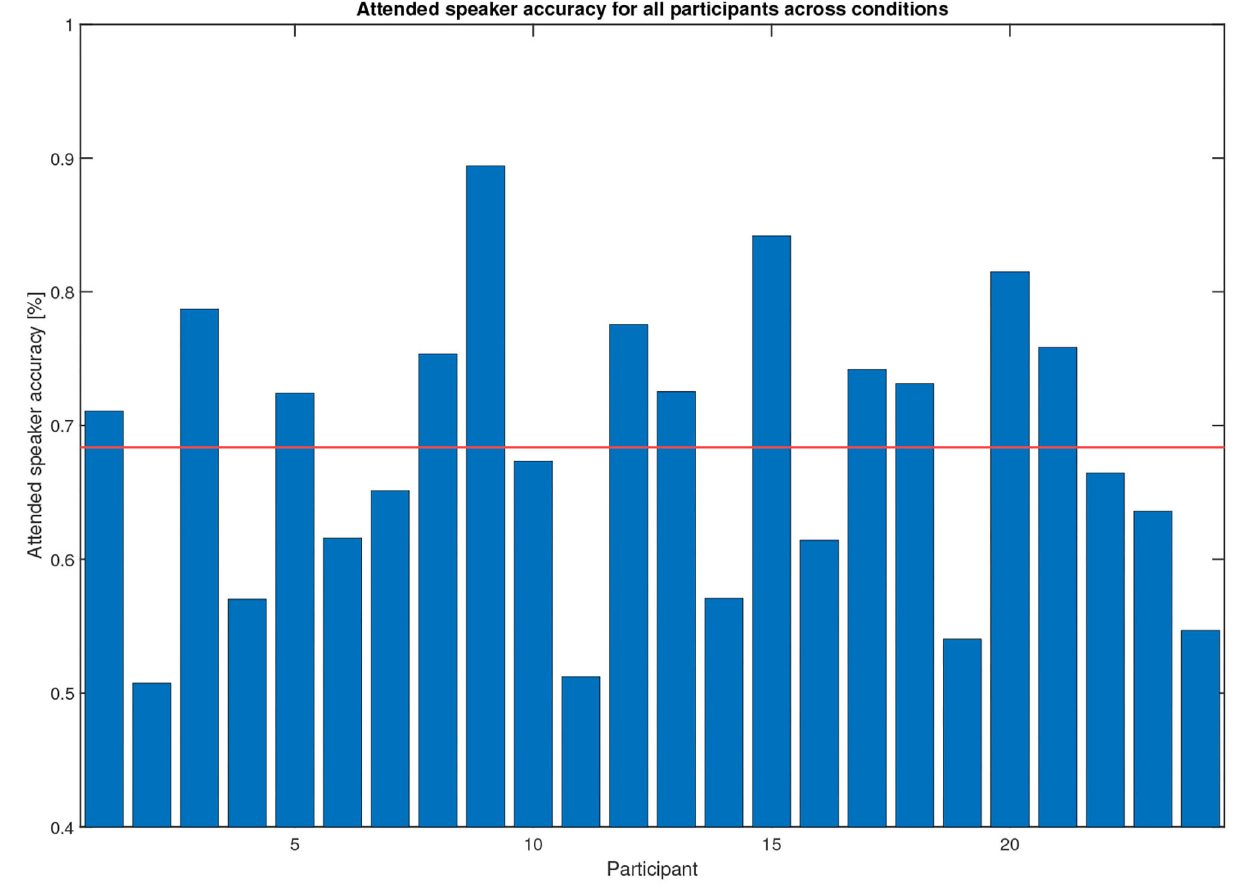
difference in the comprehension scores between the